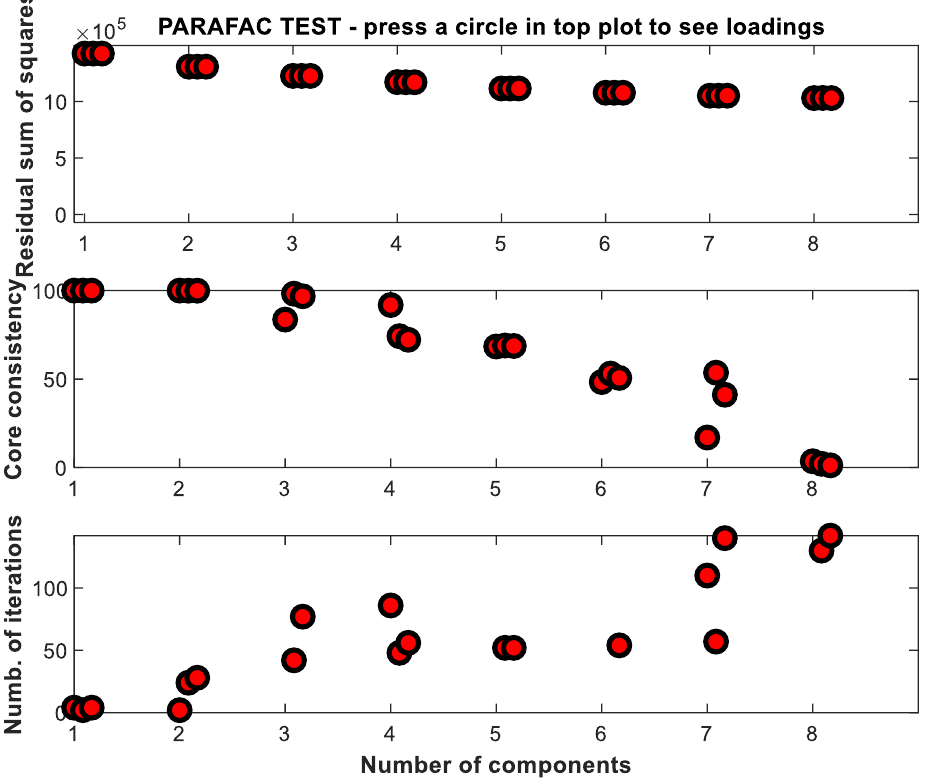
Figure 11. Nuclear consistency estimation.